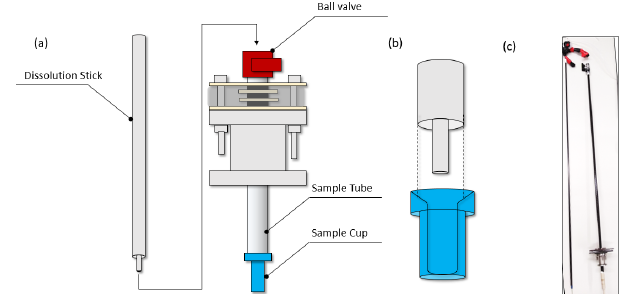
Figure 3. (a) Scheme of the dissolution system (airlock and polar- izer omitted for clarity). For a dissolution, the ball valve (red) on top of the sample tube is opened. The sample cup is lifted 100mm above the liquid-helium bath at the bottom of the cryostat. The dis- solution stick is then inserted. (b) Sketch of how the dissolution stick consisting of two coaxial capillaries (grey) is inserted into the sample cup (blue). The hot solvent is squirted onto the sam- ple through the inner capillary – the lumen between the inner and outer capillary forms the liquid outlet. (c) Image of the sample stick (left) and sample tube (right) with the seal and sample cup attached. (Image by Ludovica M.